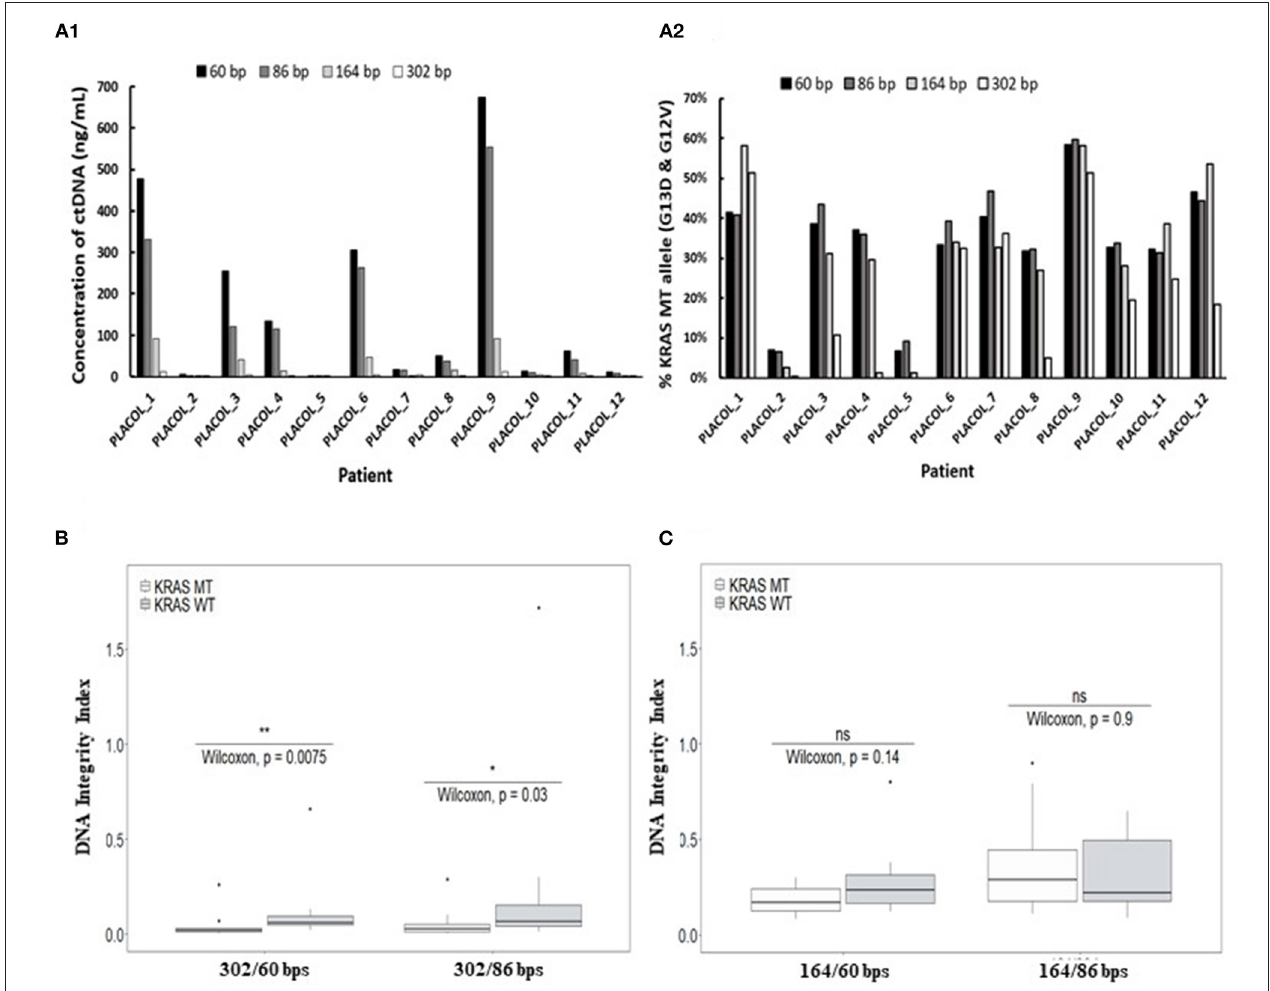
FIGURE 3 | Characterization of ctDNA by droplet-based digital PCR using assays targeting increasing amplicon sizes. Concentration of plasma ctDNA (A1) and percentage of KRAS -mutated alleles (A2) in mCRC patients and DNA integrity indexes (DII) calculated with the use of 302 bp (B) or 164 bp amplicon (C) (corresponding to the long fragments) by ddPCR. KRAS WT and MT ddPCR duplex assays amplifying different sizes of fragments (60, 86, 164, and 302 bp) were used for measuring ctDNA concentration and percentage of KRAS- mutated alleles ( A1 , A2 ) for 11 mCRC patients (one patient excluded since no 302 bp MT fragments were detectable). DII were calculated based on the amplification of sequences with different lengths as described in the section MATERIALS AND METHODS . For DII calculation, 60 bp amplicons were used as the short fragments and either 302 bp (B) or 164 bp amplicon (C) as the long fragments. Mann–Whitney U -test was used for statistical significance analysis. * p < 0.05; ** p <